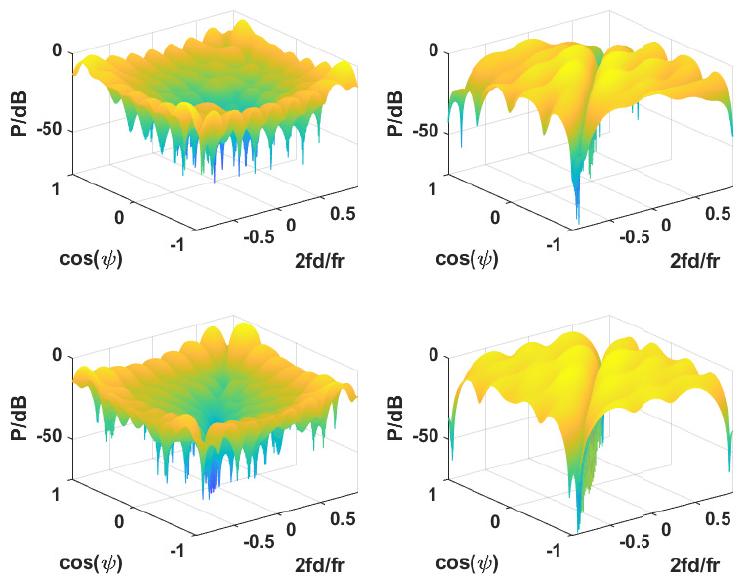
Figure 3. Frequency response of space-time two dimensions for original STAP method ( left ) and proposed method ( right